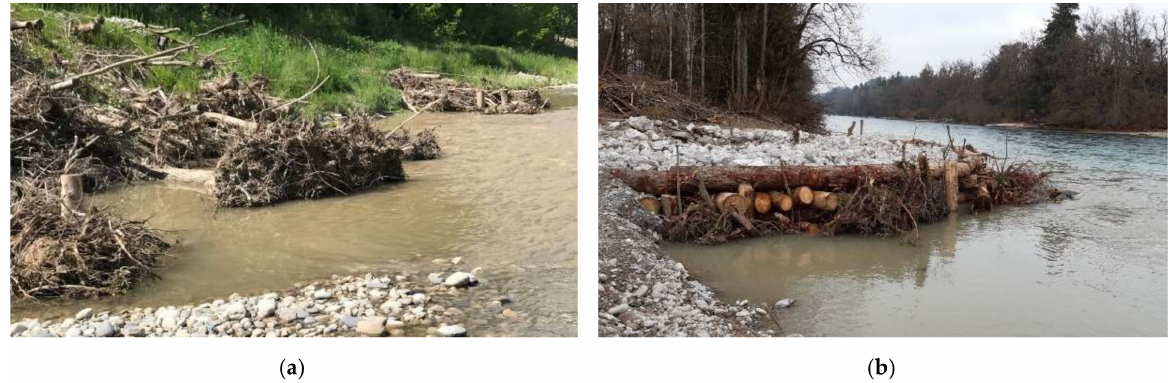
Figure 5. ( a ) Deeply founded tree trunks for bank stabilization and structuring; Emme river; Photo: M. Mende. ( b ) Engineered log jam shortly after completion; Aare river; Photo: Courtesy of D.